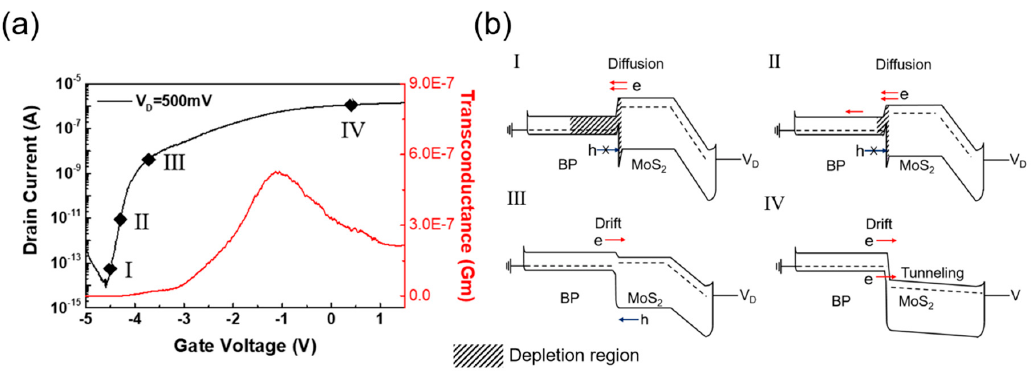
Figure 3. Electrical properties and current flow mechanism of a MoS 2 /BP heterojunction FET at V D = 500 mV. ( a ) Transfer characteristics and transconductance (G m ). ( b ) Band diagrams showing the states at different gate bias regions.